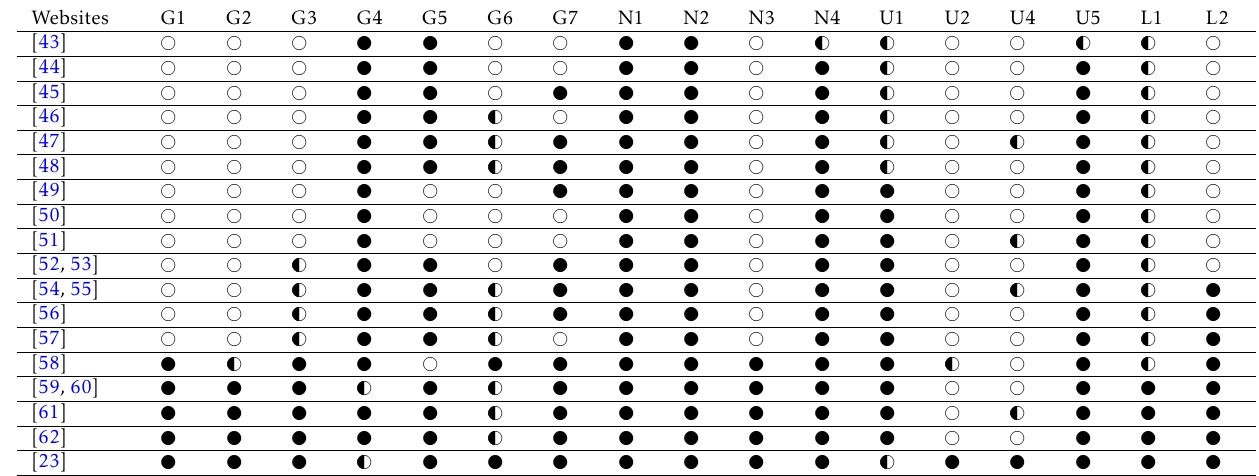
Table 2. Implementation of the accessibility guidelines in the current websites.